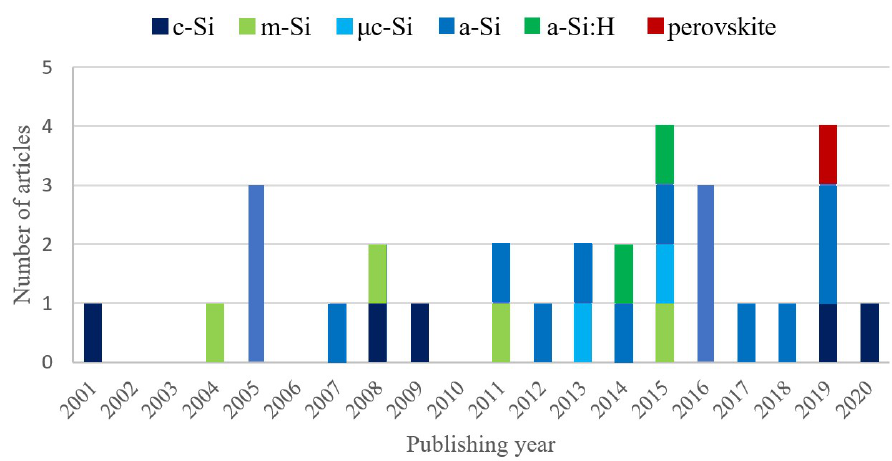
Figure 7. Types of PV cells included in simulation research of T- and ST-BIPV.